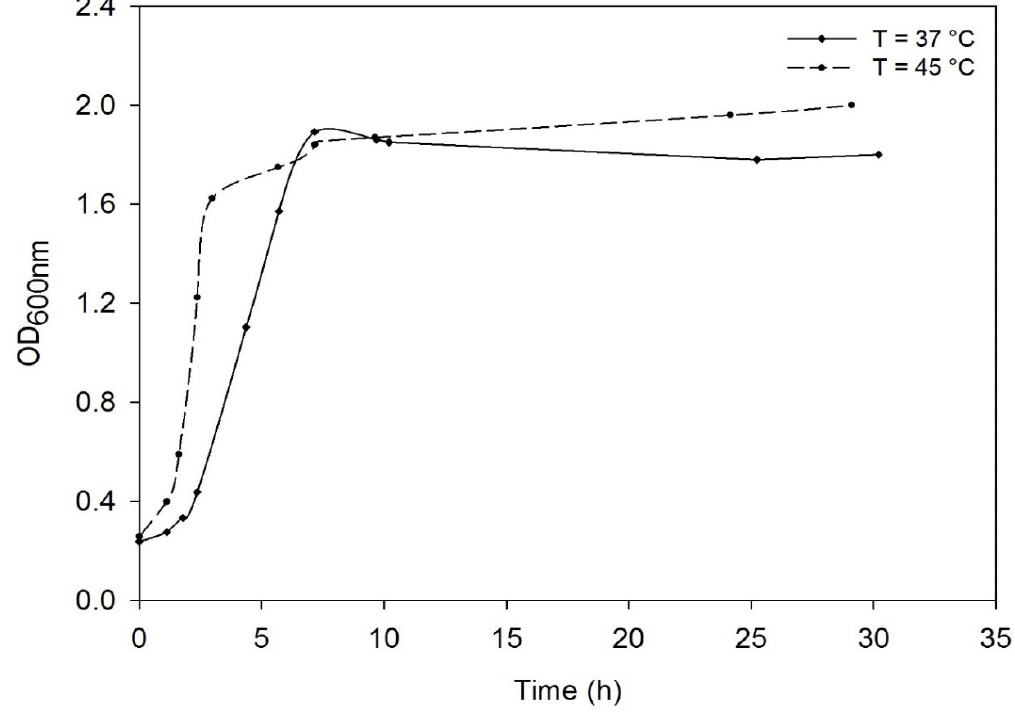
Figure 1. Comparison of growth curve of Deinococcus geothermalis (Deutsche Sammlung von Mikroorganismen, DSM) DSM-11302 at 37 °C and 45 °C in Complex Medium